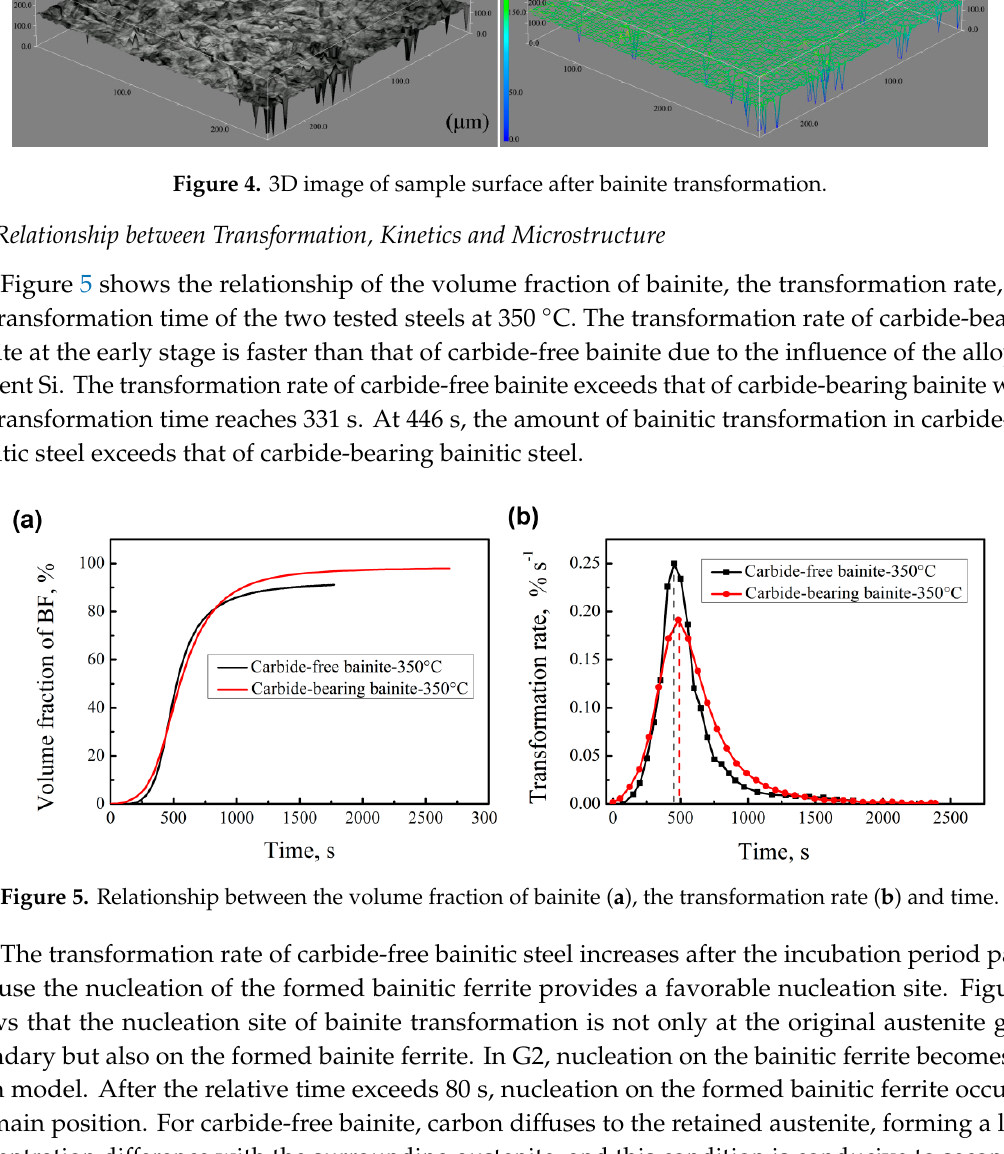
Figure 5. Relationship between the volume fraction of bainite ( a ), the transformation rate ( b ) and time.